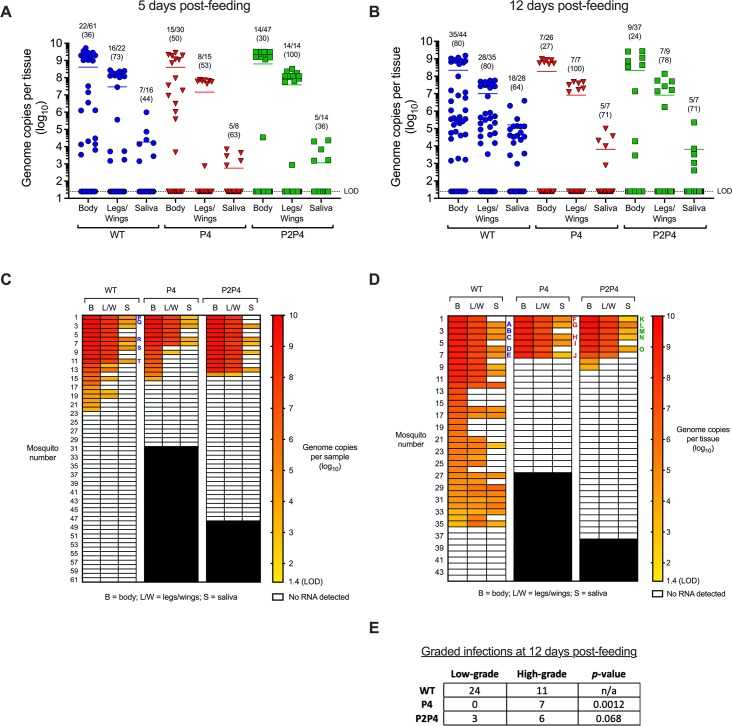
Infection, dissemination, and transmission of WT and fidelity variant CHIKV at 5 (A and C) or 12 days post-feeding (B and D). Data for WT are same as Fig 1. For A and B, each symbol represents an individual mosquito, lines represent mean CHIKV RNA titers, and proportions of positive samples with percentages (in parentheses) are shown above groups. For reported proportions, the denominator for legs/wings and saliva samples are the number of infected bodies and number of disseminated infections, respectively. For C and D, samples from individual mosquitoes are arranged horizontally. LOD = limit of detection. Individual mosquito samples selected for sequencing are labeled in C and D with corresponding mosquito identifying letters A to T. E) Infected bodies at 12 days post-feeding were designated as low-grade (<8 log10 genome copies) or high-grade (>8 log10 genome copies). Proportions of low-grade infections for P4 and P2P4 were compared against WT by Fisher exact test, p-values are listed. The data for WT-infected mosquitoes presented here are the same as presented in Fig 1A and 1B.